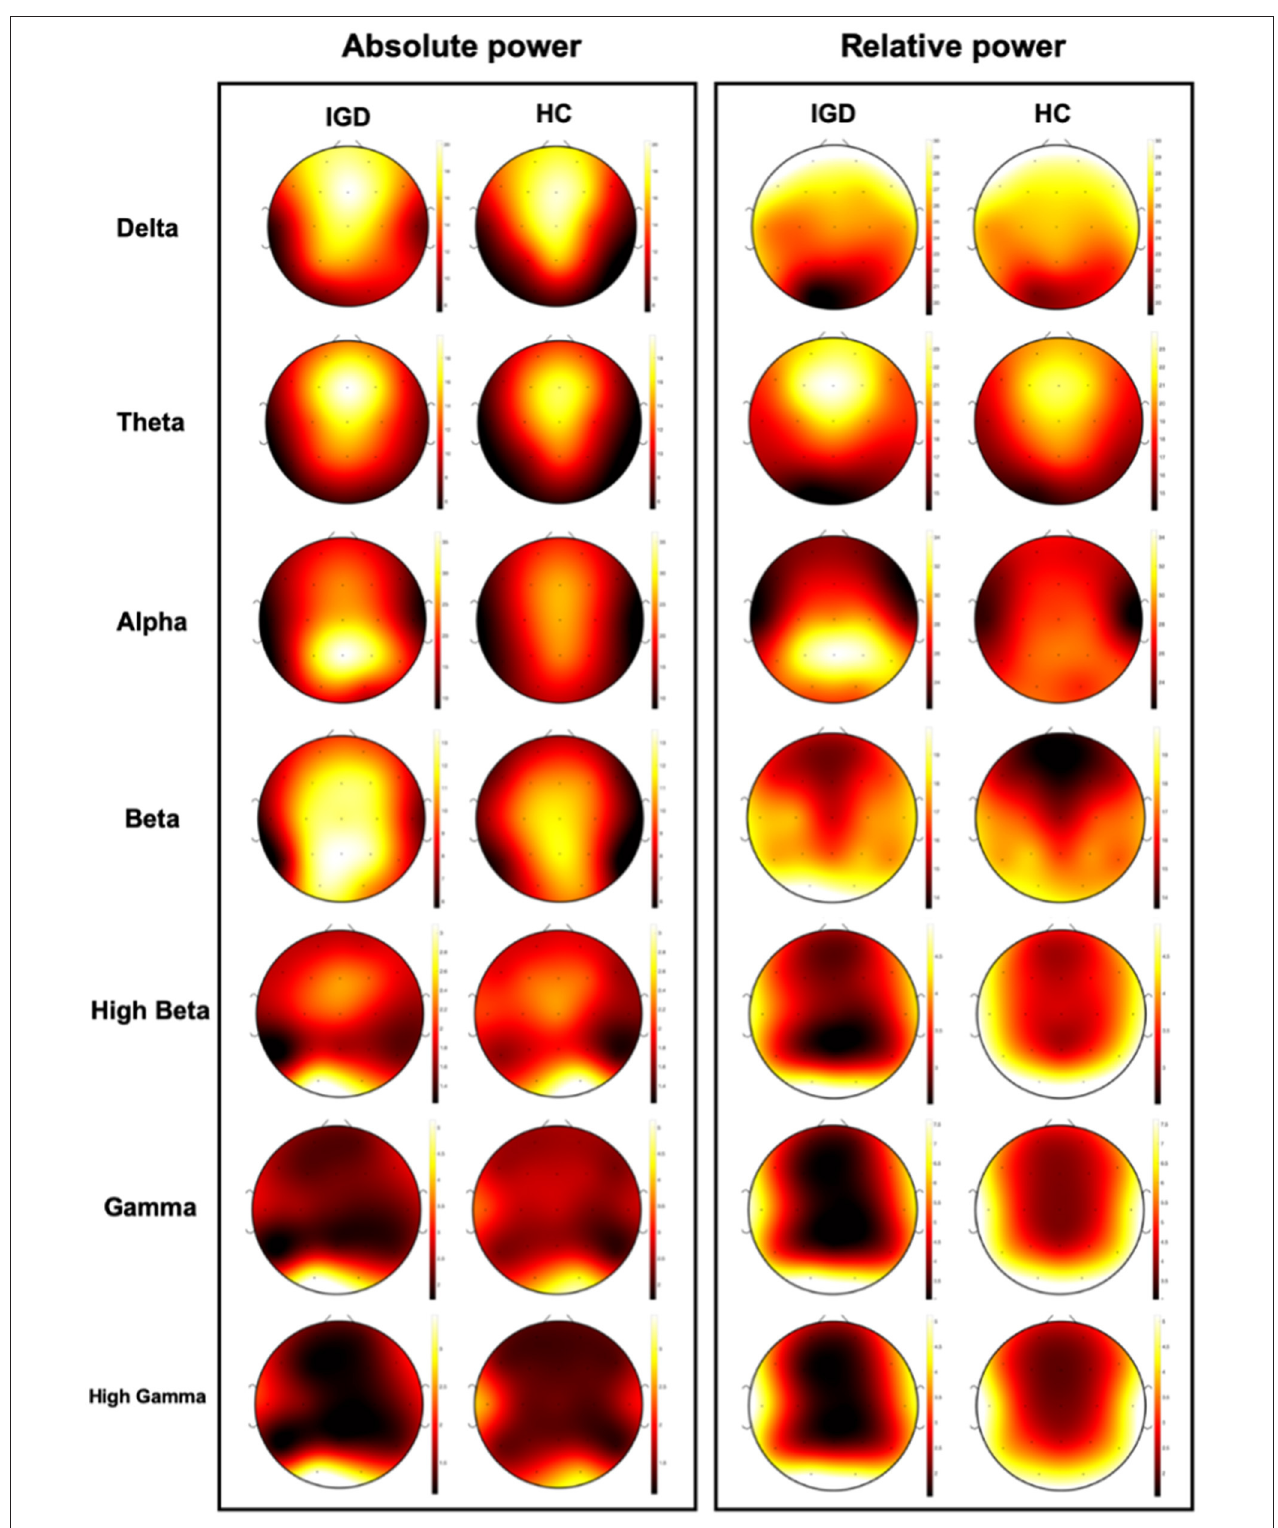
FIGURE 1 | Visualization of mean absolute power and relative power of EEG data for IGD and Health control (HC) group.